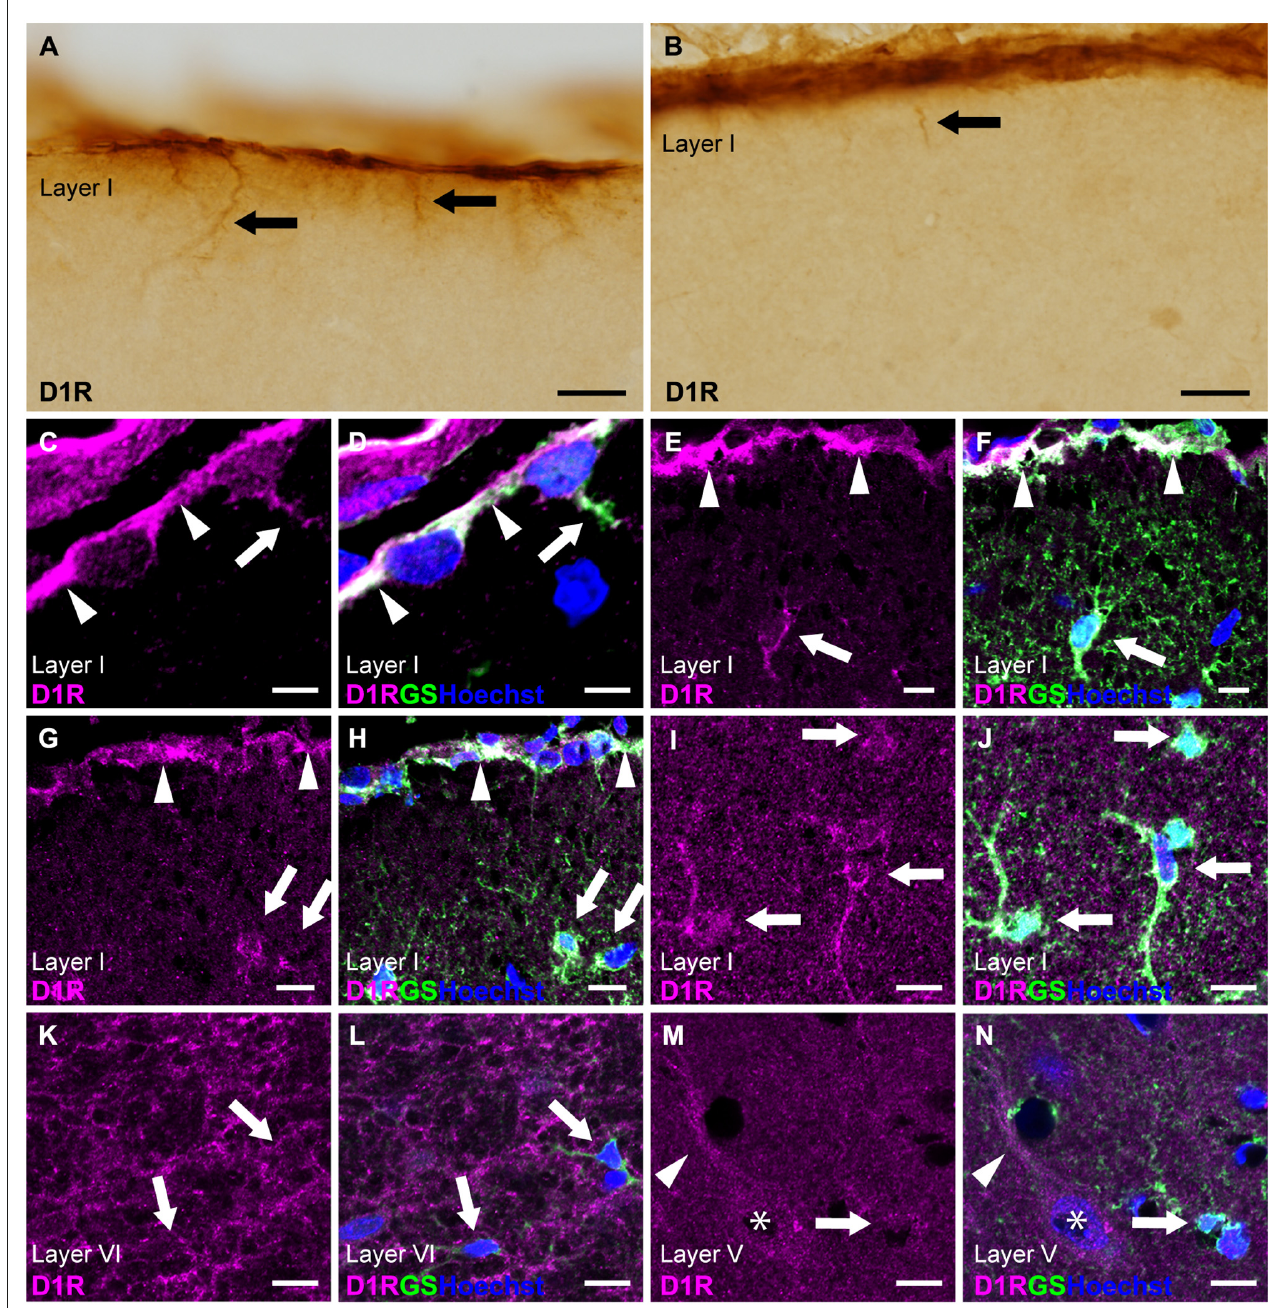
FIGURE2 D1R-immunoreactivity in astrocytes. (A,B) D1R-immunopositive signals in the cortical surface of the prelimbic (A) and somatosensory (B) areas. Arrows indicate D1R-immunolabeled processes of pial astrocytes. (C,D) Confocal imaging of double immunostaining for D1R (magenta) and GS (green) indicated strong D1R-immunoreactivities of the somata (arrowheads) and process (arrows) of pial astrocytes in the prelimbic area. (E,F) Confocal imaging of double immunostaining for D1R (magenta) and GS (green) indicated strong D1R-immunoreactivities of pial astrocytes (arrowheads) and layer I astrocytes (white arrows) in the primary motor area. (G,H) Confocal imaging of double immunostaining for D1R (magenta) and GS (green) indicated strong D1R-immunoreactivities of pial astrocytes (arrowheads) and layer I astrocytes (white arrows) in the somatosensory area. (I,J) Confocal imaging of double immunostaining for D1R (magenta) and GS (green) indicated strong D1R-immunoreactivities of layer I astrocytes (arrows) in the primary motor area. (K,L) In layer VI of the primary motor area, reticular D1R-immunoreactivities were observed. GS-positive protoplasmic astrocytes had weak immunoreactivities for D1R (arrows). (M,N) In layer V of the primary motor area, protoplasmic astrocytes (arrows) had weak D1R-immunoreactivity. D1R-immunoreactivities were found in pyramidal cells (asterisks) and their apical dendrites (arrowheads). Nuclei were stained with Hoechst33342. Scale bars: 20 µ m (A,B) ; 5 µ m (C,D) , 10 µ m (E–N)